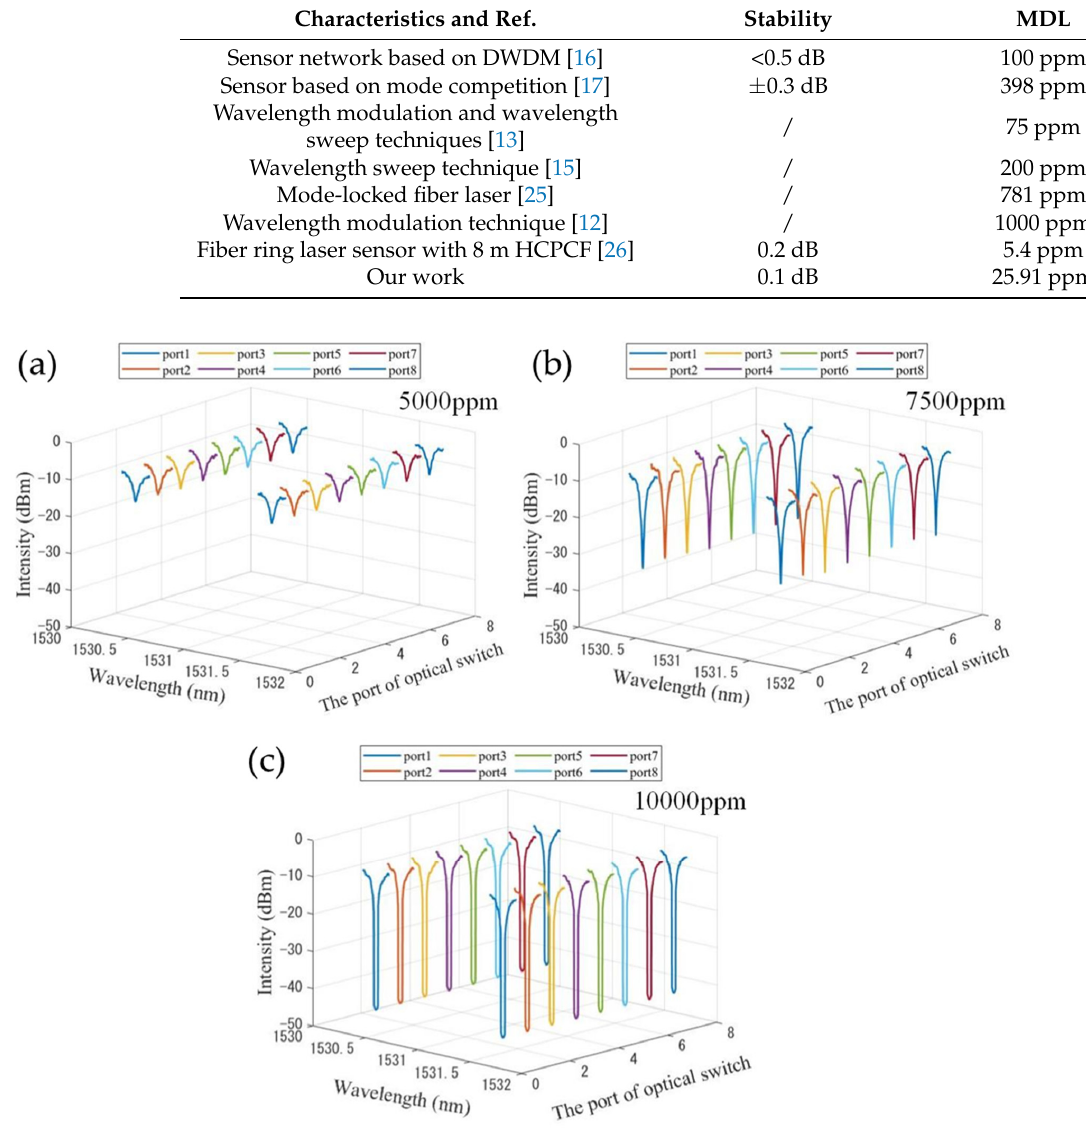
Figure 7. The absorption spectra with different optical switch ports when the acetylene concentra-